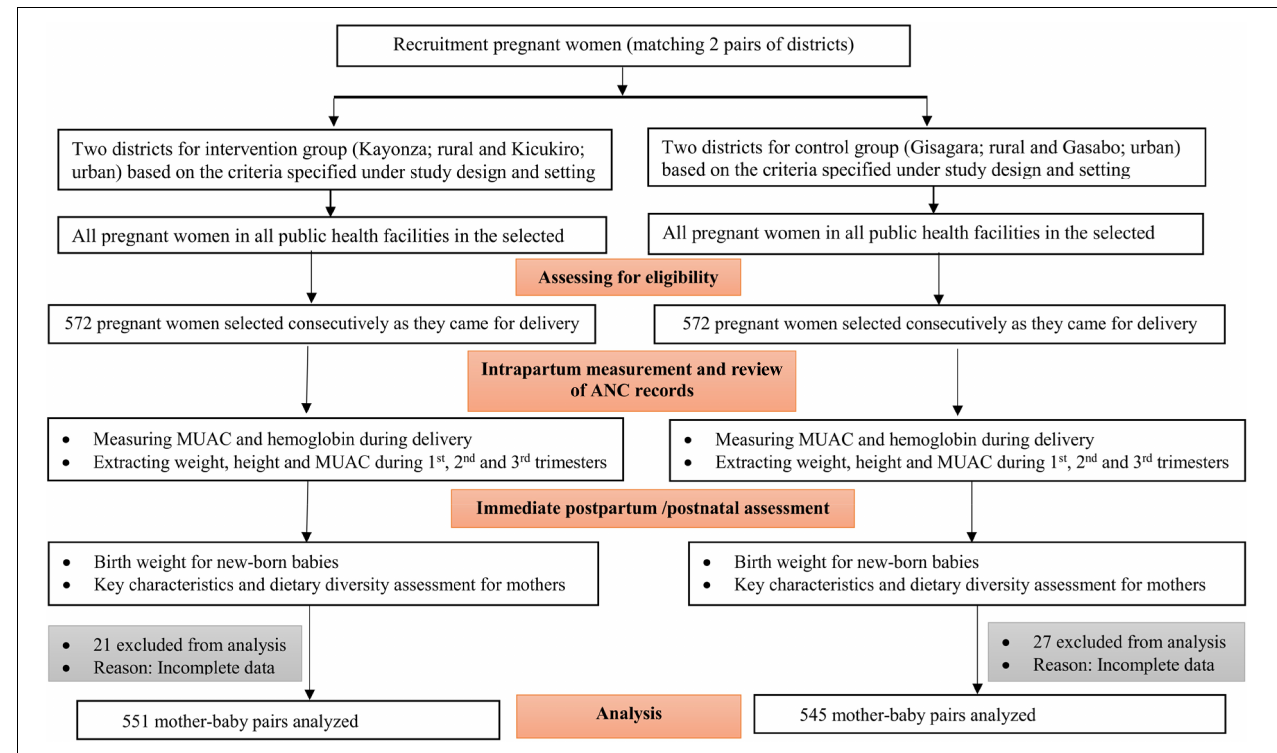
FIGURE 1 | Recruitment flow